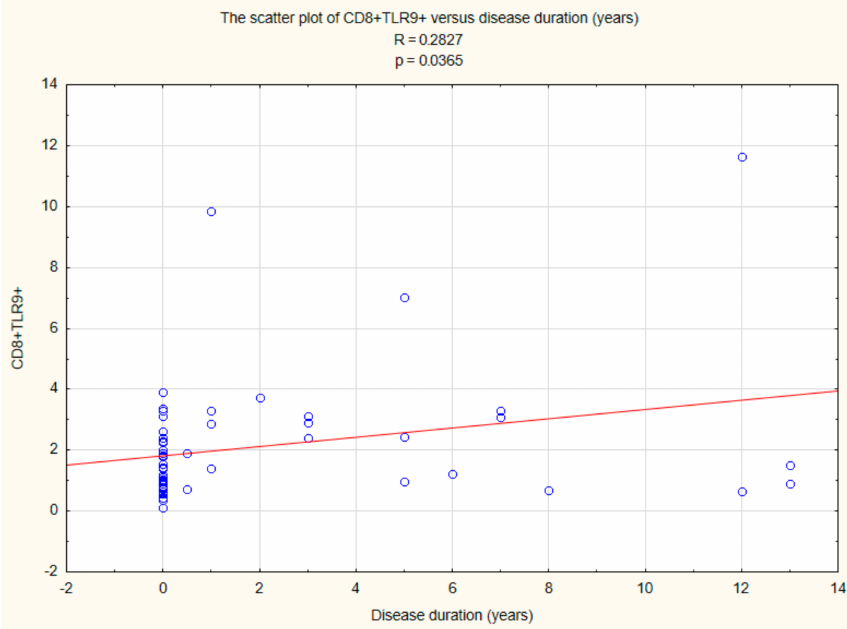
Figure 9. Relationship between CD8+ TLR9+ T cells and duration time after the onset of